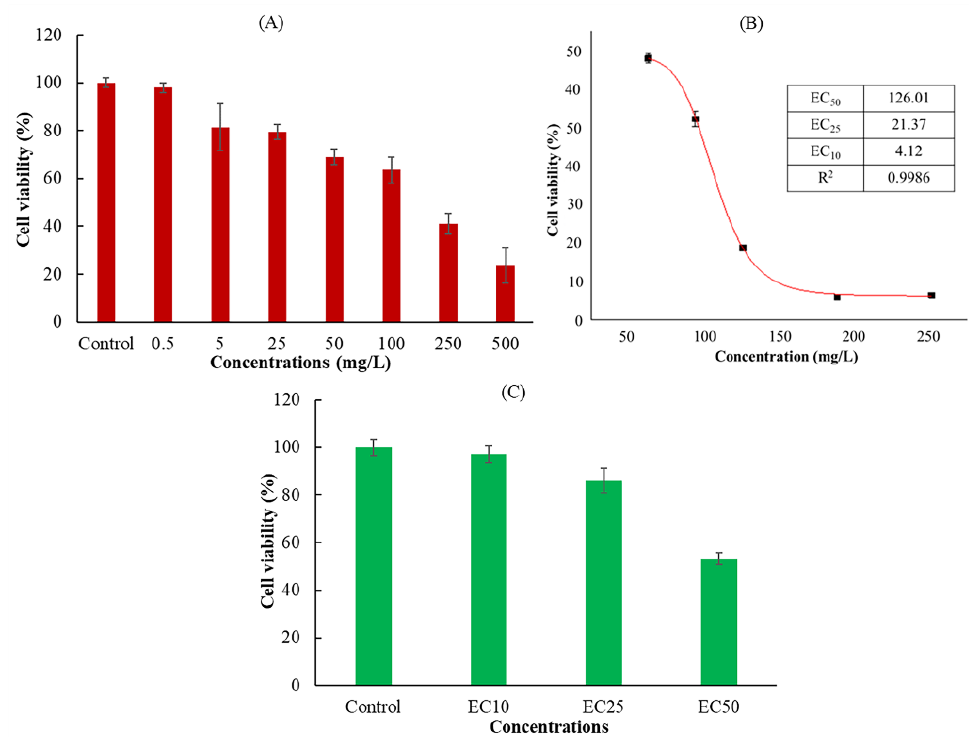
Figure 1. Effect of dimethomorph on Jurkat T cells viability. ( A ) Jurkat cells exposed for 36 h at different DMM concentrations or controls. ( B ) Nonlinear curve fitting results of different effective concentration (EC) using the results of ( A ). ( C ) Jurkat T cells exposed for 36 h to EC 50 , EC 25 , EC 10 DMM, or controls. Cell viability is presented as a percentage compared to the control. The results shown are the mean ± SD from triplicate exposures.